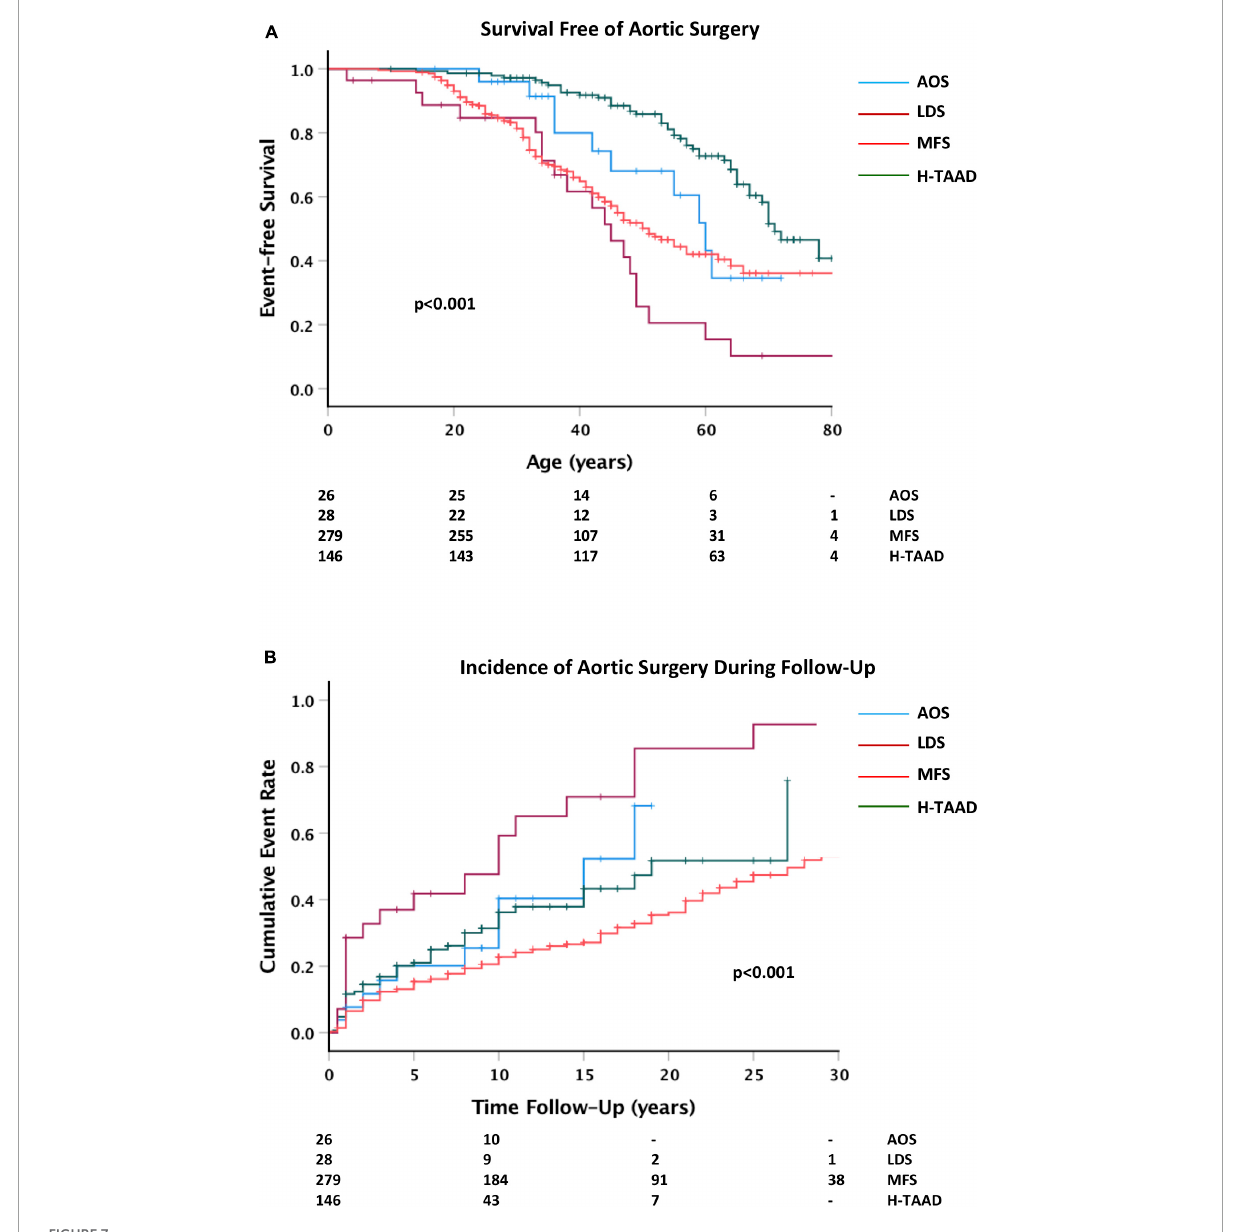
FIGURE7 (A) Comparative survival free of aortic surgery, according to age at surgery or last follow-up. (B) Cumulative event rate for aortic surgery, according to length of follow-up. Abbreviations as per text. Numbers at risk shown at bottom of plots.